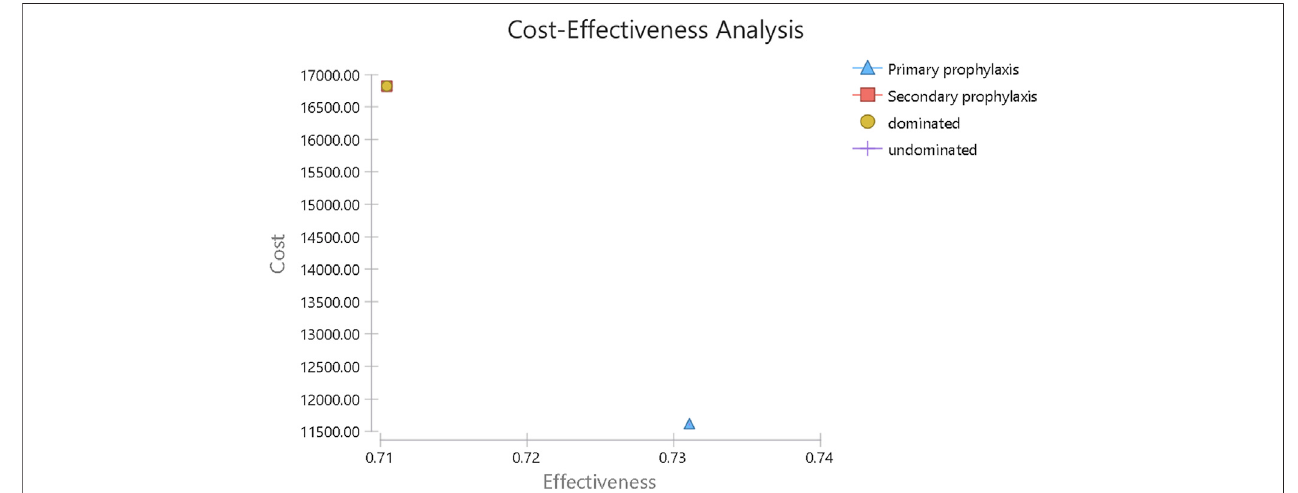
FIGURE 1 | Incremental cost-effectiveness ratio of cost-effectiveness analysis.